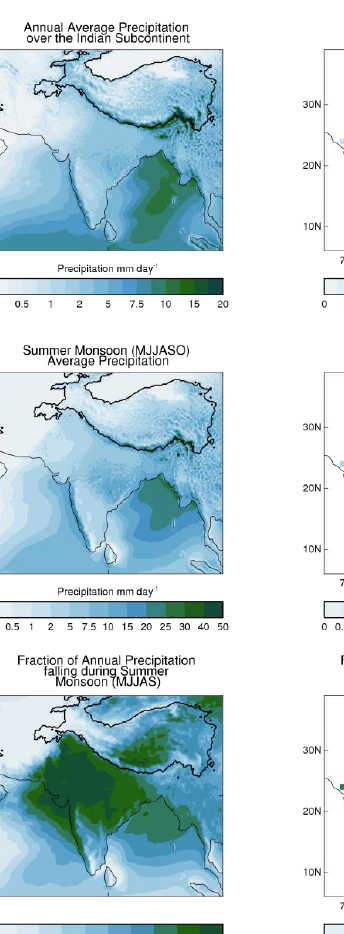
Figure 1. Annual mean air temperature of the Indian Subcontinent (1992–2007) as simulated by downscaling ERA-Interim reanalysis using Figure 1: Annual mean air temperature of the Indian Subcontinent (1992-2007) as simulated by 795 the HadRM3 regional climate model compared to CRU observations. The region above 2500ma.s.l. is indicated. Note that the RCM data downscaling ERA-Interim reanalysis using the HadRM3 regional climate model compared to CRU 796 are on a rotated pole projection. observations. The region above 2500 m a.s.l. is indicated. Note that the RCM data are on a rotated 797 pole projection. 798